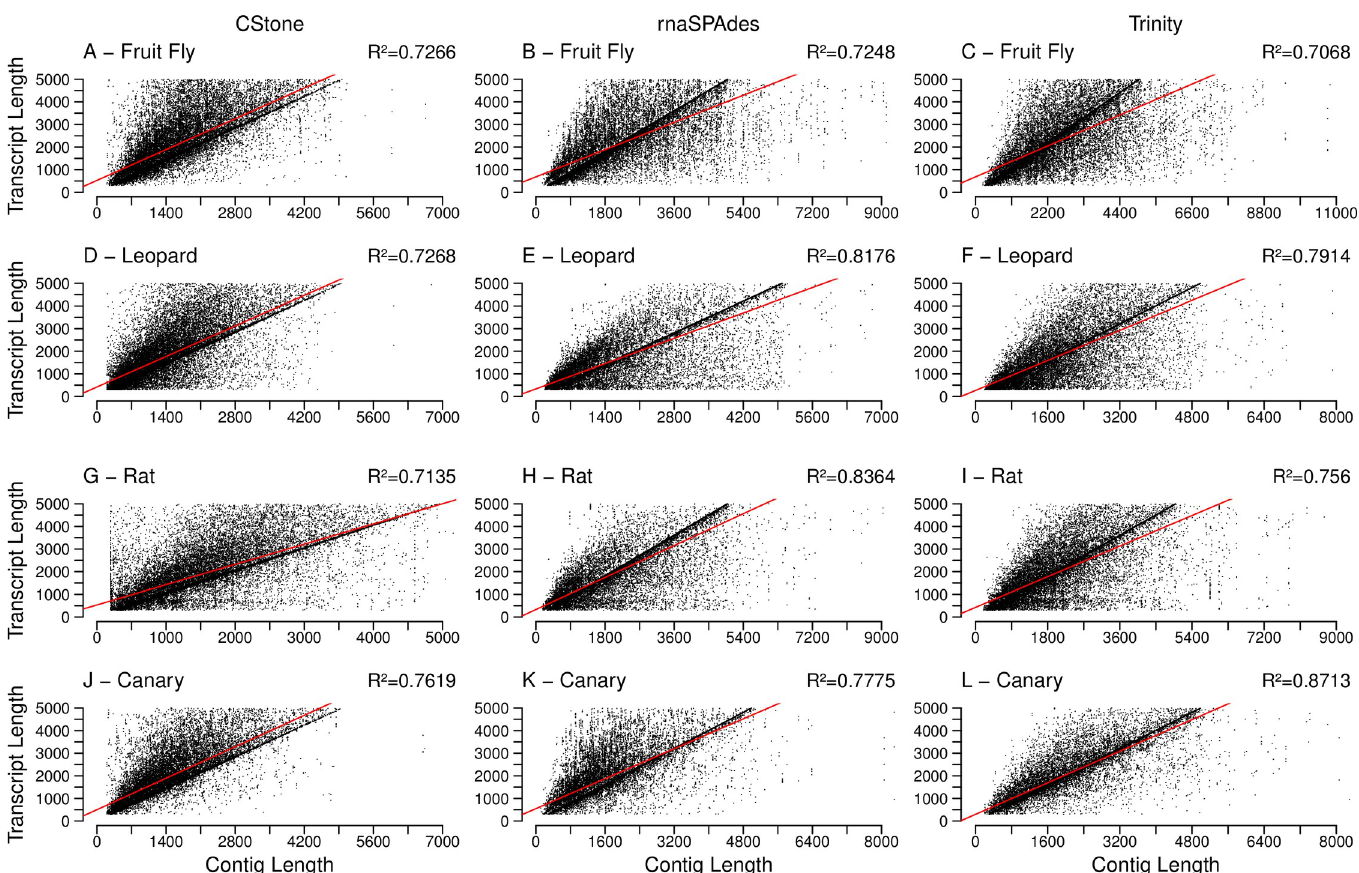
Fig 7. Length of contigs versus length of reference transcript. R 2 values, located on the top right corners, indicate the correlation between cDNA reference transcript lengths and contig lengths. The description of the rest of the figure is identical to that of Fig